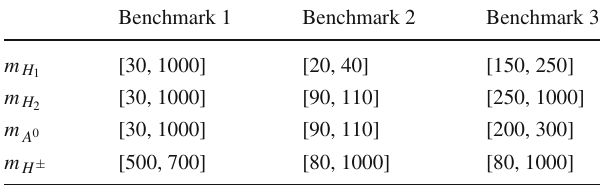
Table 3 Mass ranges (in GeV) of the new scalars used in each bench-